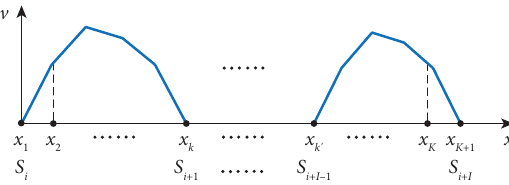
Figure 2: Te illustration of multisection discretizing.